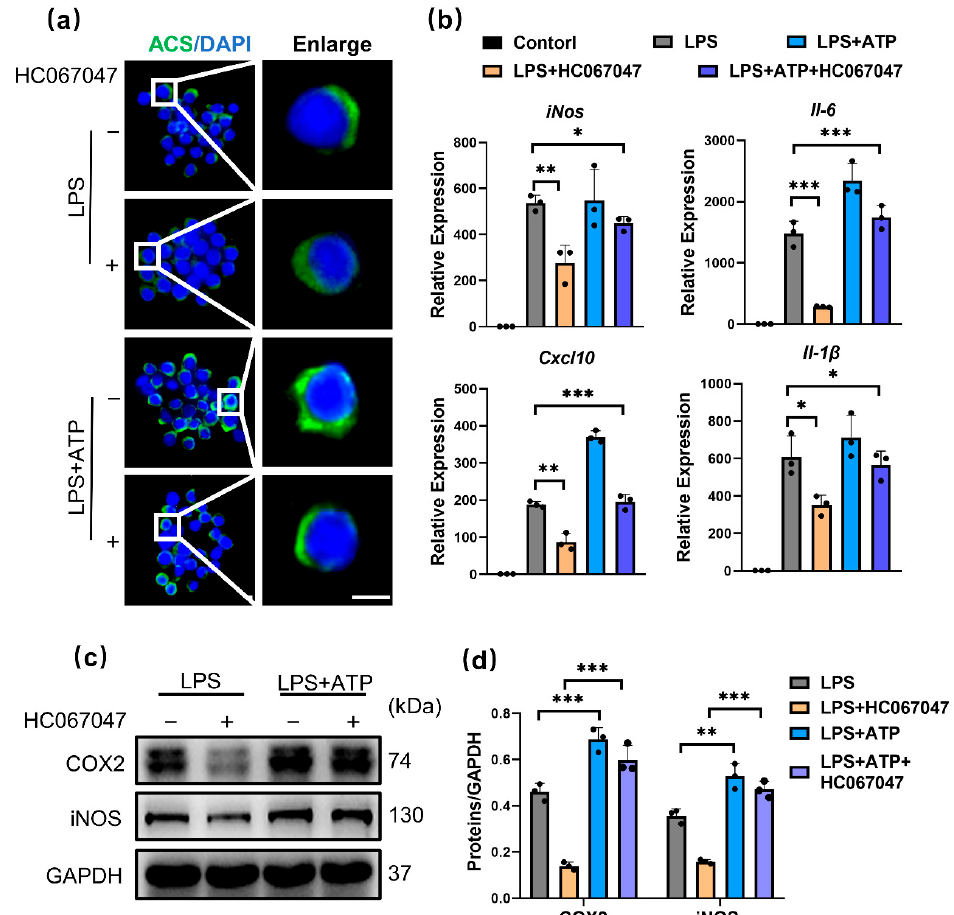
Figure 5. TRPV4 inhibition prevents M1 macrophage polarization by blocking the NLRP3 inflammasome. ( a ) Immunofluorescence of ASC in cells pretreated with 100ng/mL LPS or LPS + 10 µmol/L HC067047 for 6 h, without or with 5 nmol/L ATP for 1 h. ( b ) iNos, Il-6, Cxcl-10, and Il-1 β mRNA levels in the control, LPS, LPS + HC067047, LPS + ATP, and LPS + ATP + HC067047 groups. n = 3. ANOVA with Tukey’s post-hoc test, * p < 0.05; ** p < 0.01; *** p < 0.001. ( c ) COX2 and iNOS protein levels in RAW264.7 cells pretreated with LPS or LPS + HC067047 for 24 h, without or with 2 nmol/L ATP for 3 h. ( d ) Quantitative analysis of Western blotting. n = 3. One-way ANOVA with Tukey’s post-hoc test, ** p < 0.01; *** p < 0.001. All data are shown as mean ± SD.